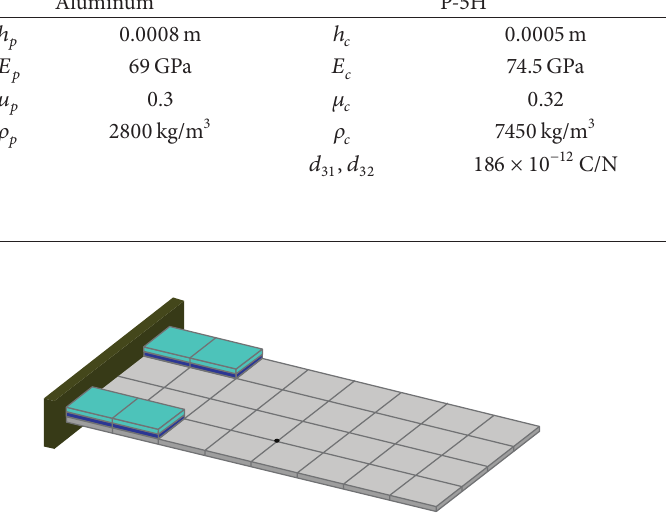
Figure 3: The schematic diagram of finite element grid for ACLD/plate.